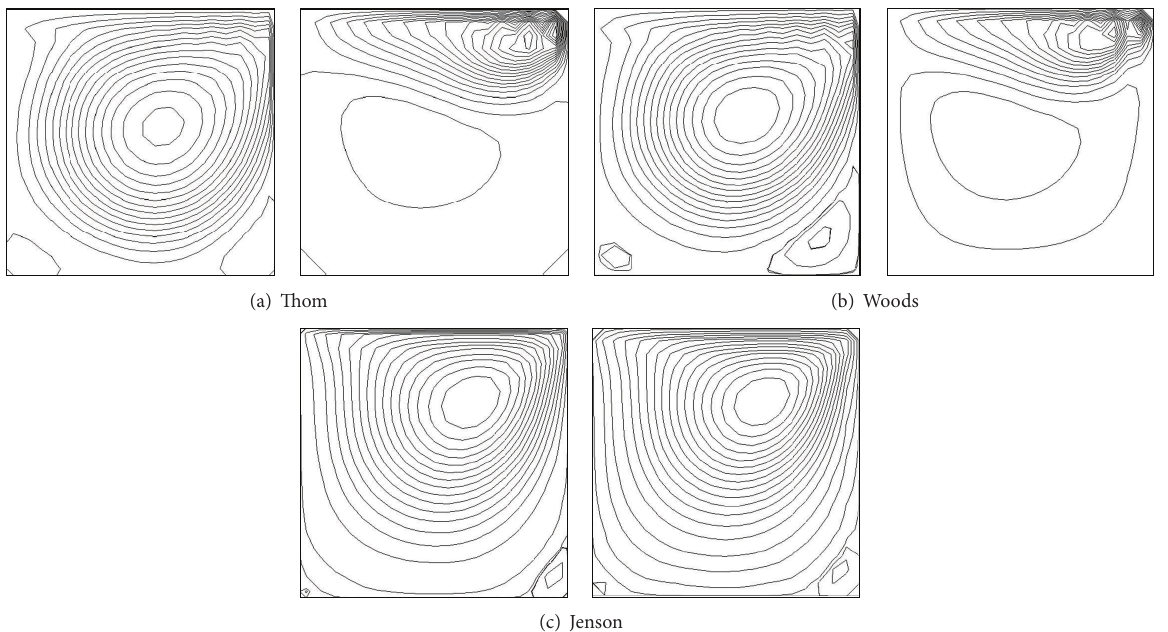
Figure 9: Stream functions of lid-driven flow under variant boundary treatments with the grid of 20×20 (FVM in the left column and FDM in the right